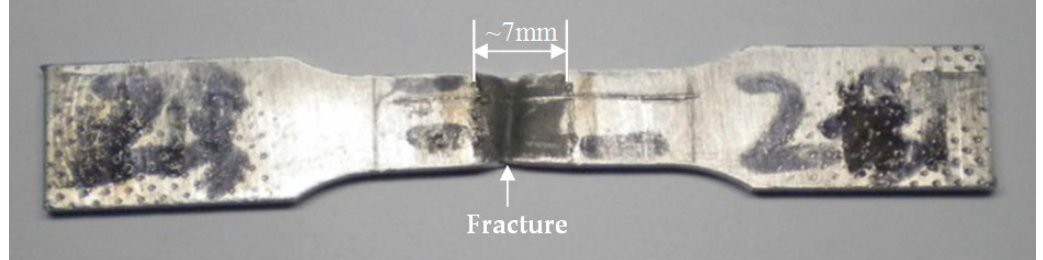
Figure 4. The appearance of FSW welded specimen after tensile test, showing the fracture was occurred in the gage